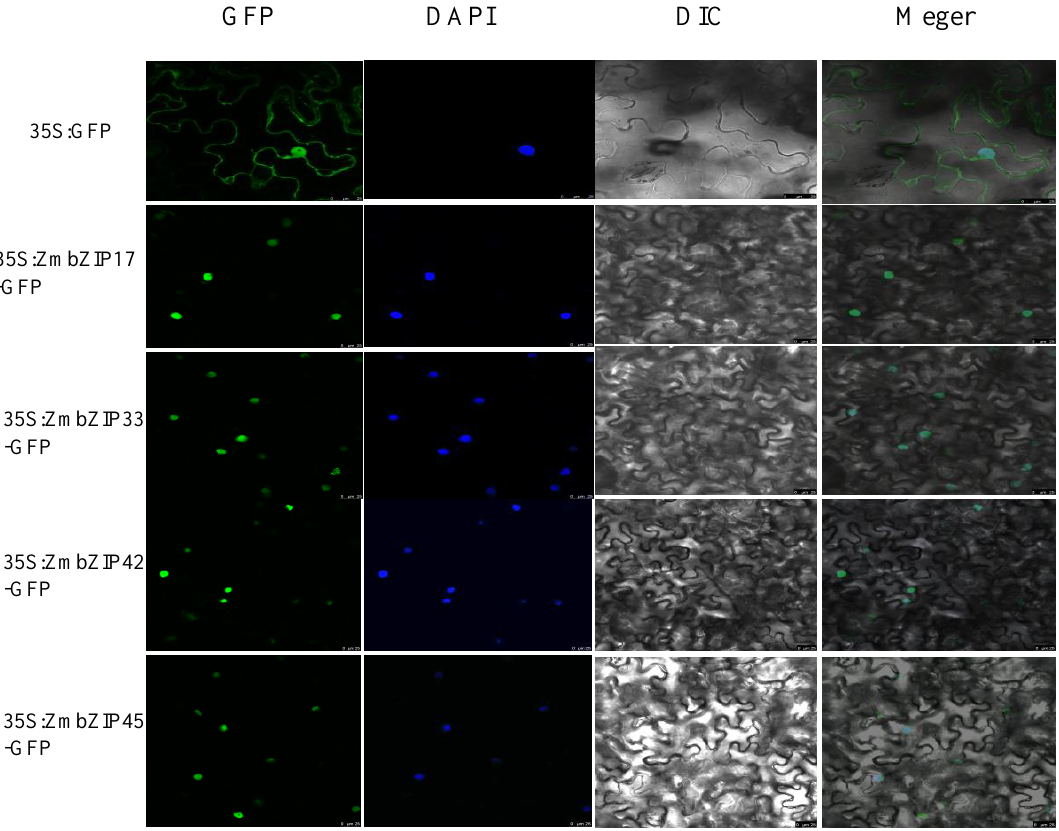
Figure 11. Subcellular localization of ZmbZIP17-GFP, ZmbZIP33-GFP, ZmbZIP42-GFP, and ZmbZIP45-GFP fusion protein. Fusion proteins were transiently expressed under control of the CaMV35S promoter in tobacco leaves and observed under a laser scanning confocal microscope. The green color is the green fluorescent protein (GFP) signal, and the blue color represents 4’,6 -diamidino-2-phenylindole (DAPI), stained for the nucleus. Differential interference difference (DIC) . Scale Bars = 25 μm.